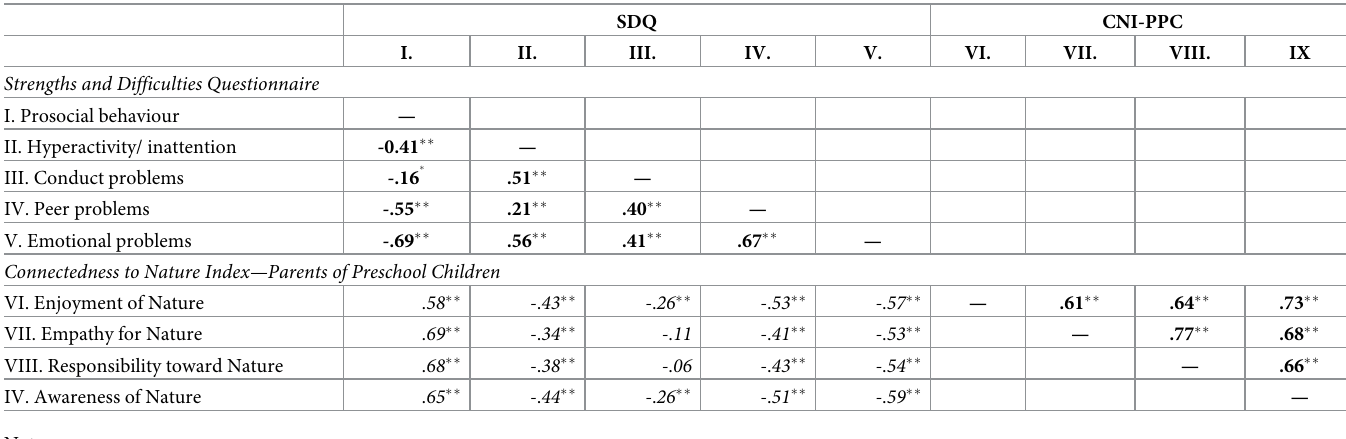
Table 3. Inter-correlations within and between the CNI-PPC and SDQ